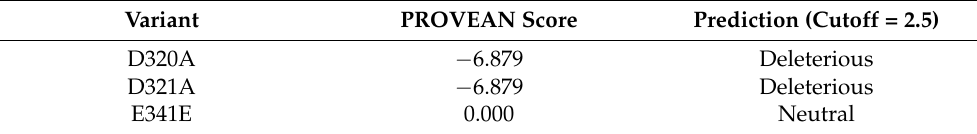
Table 9. Prediction and scores generated by the PROVEAN tool.